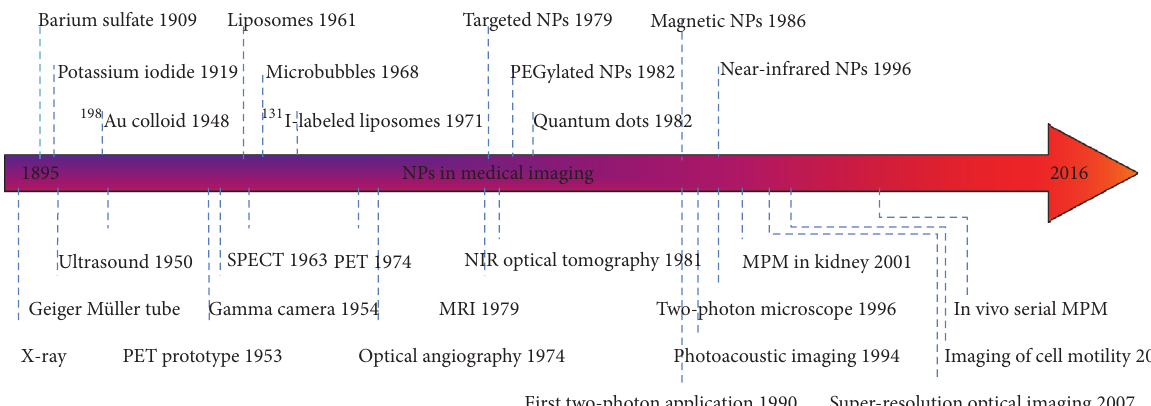
Figure 3: Development of NPs as medical imaging contrast agents over the past